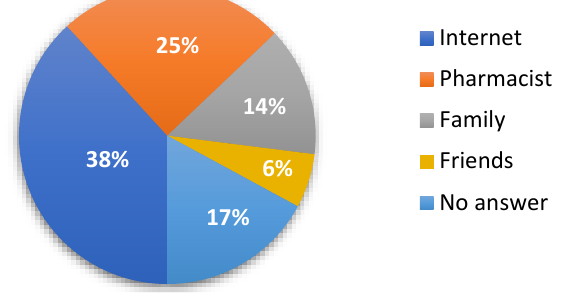
Figure 4. Source of medical advice in case of lack of contact with a doctor.